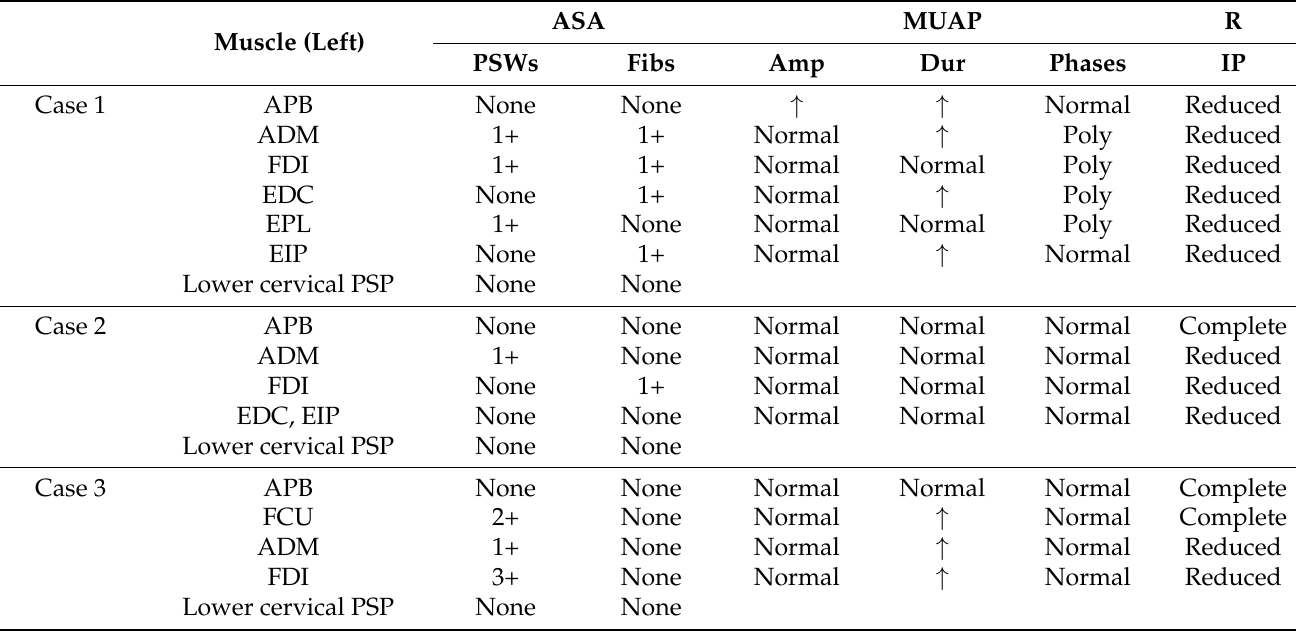
Table 2. Results of needle